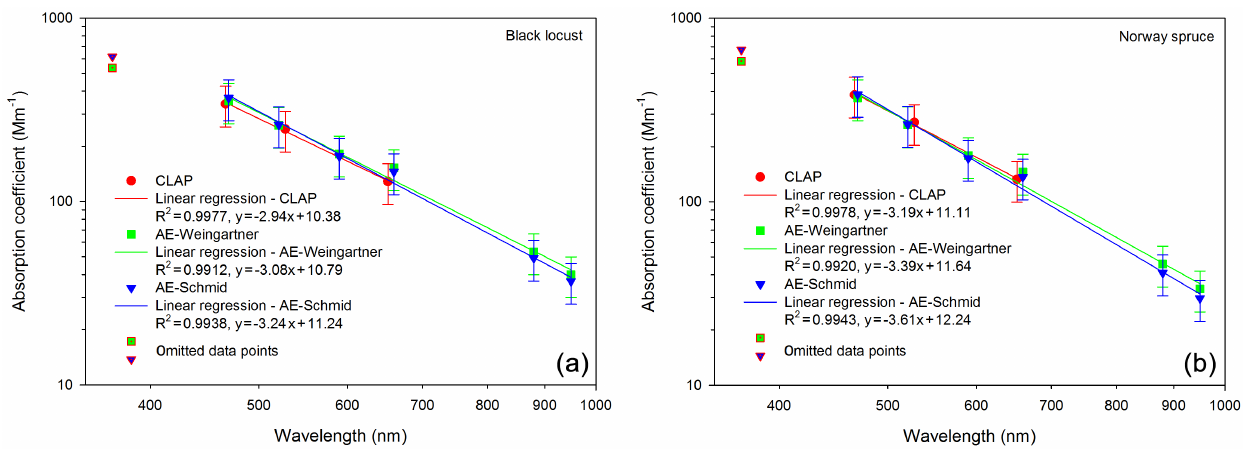
Figure 3. Absorption Ångström exponent of tar balls prepared from the liquid distillate of black locust and Norway spruce. The linear equations are calculated for the log A vs. logλ values (the data are also available in Table S1 in the